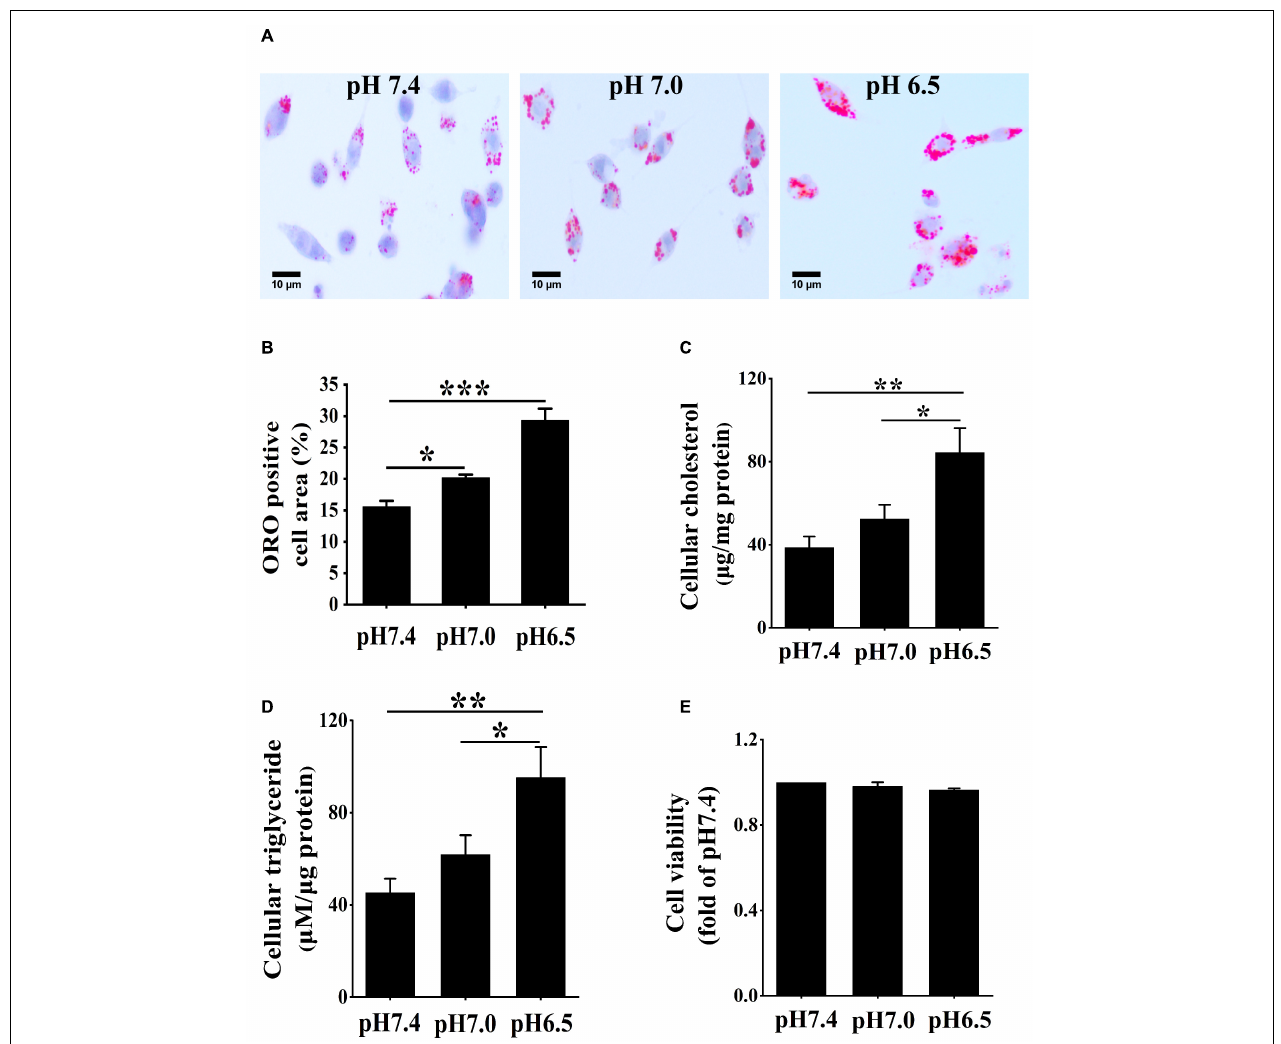
FIGURE 1 | Extracellular acidification aggregates lipid deposition in macrophages. (A) RAW 264.7 cells were cultured in 25 µ g/ml oxidized low-density lipoprotein (ox-LDL) in different pH media for 24 h. Lipid accumulation was detected by Oil red O (ORO) staining. (B) ORO staining positive areas were quantified. (C,D) Intracellular cholesterol and triglycerides contents were determined by enzymatic assay. (E) CCK-8 kit was used to detect cell viability and proliferation. Results are expressed as the mean ± SEM. Statistical analysis was performed by one-way analysis of variance (ANOVA). * P < 0.05; ** P < 0.01; *** P <